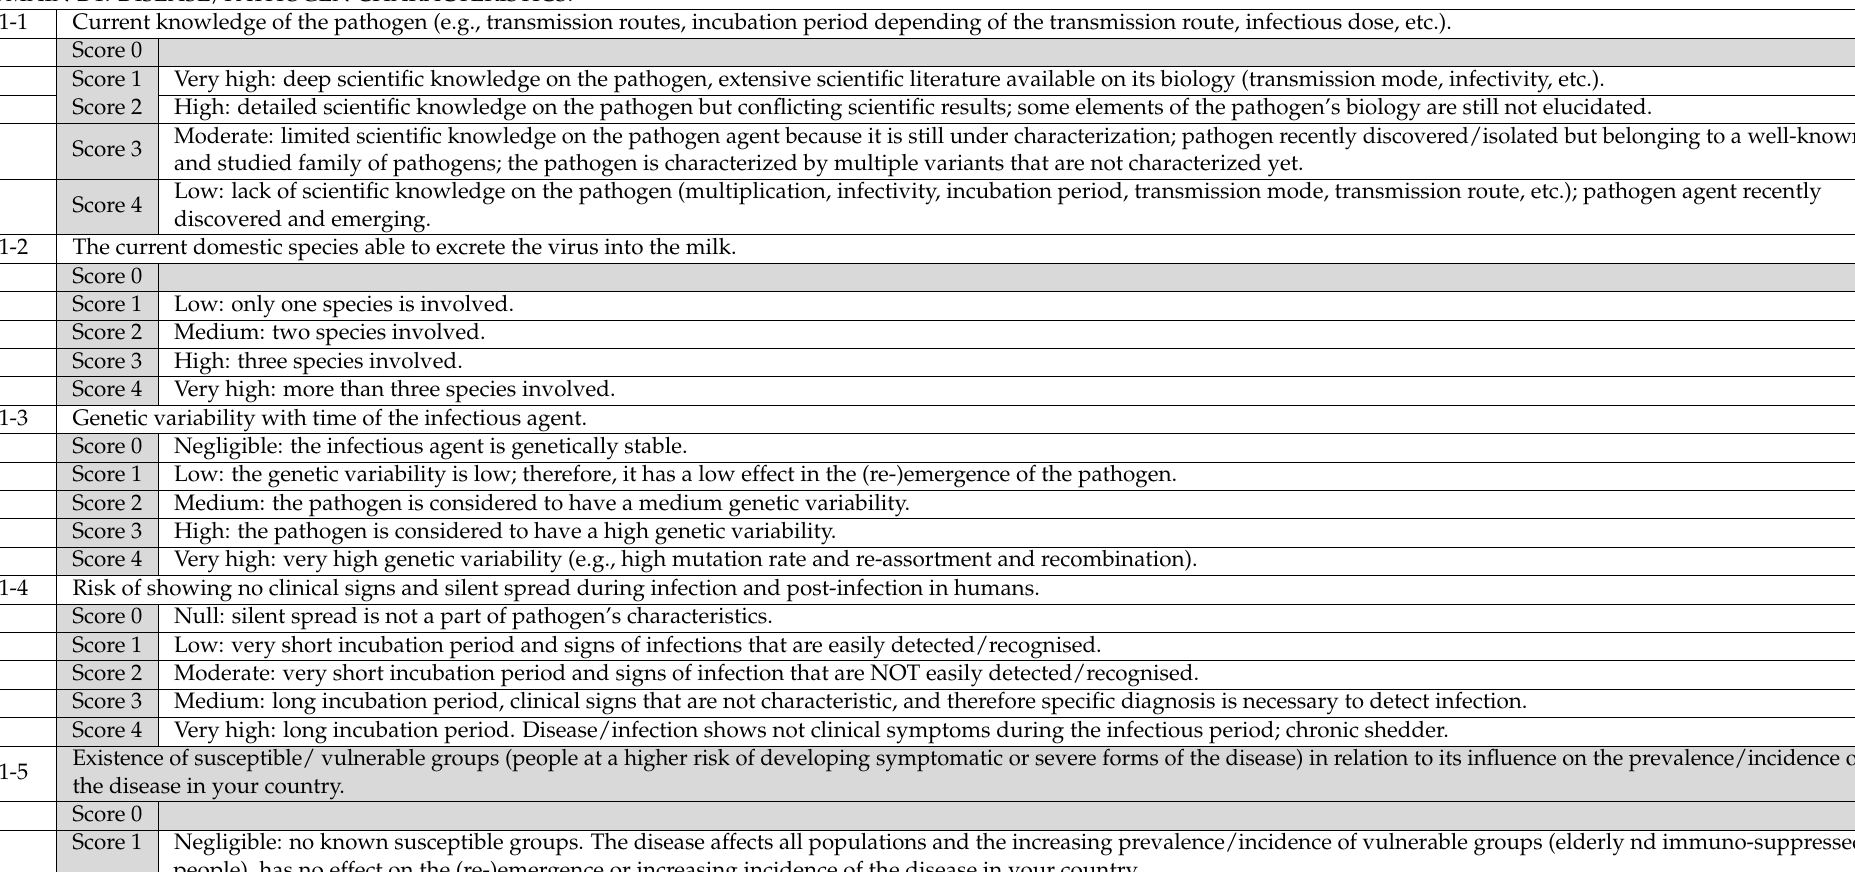
Table A1. Domains of Each Defined Driver and Their Respective Defined Coefficients